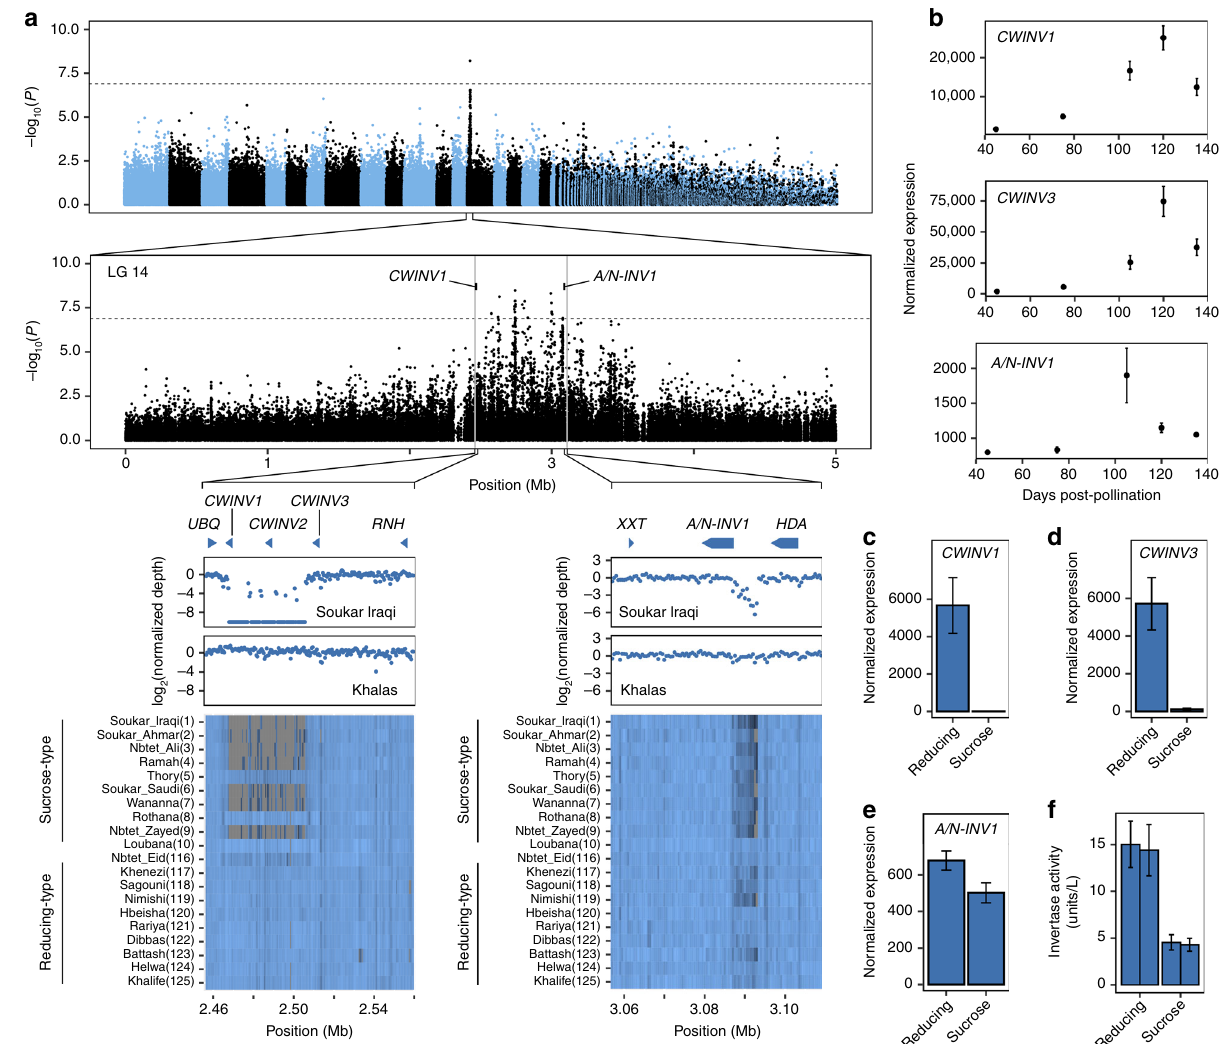
Fig. 5 GWAS mapping of sugar composition in date palm fruit and functional characterization of candidate genes. a Top: Manhattan plot GWAS results for tamar stage fruit sugar composition measured as [sucrose]/[sucrose + glucose + fructose]. The plot is based on analysis conducted with the randomly downsampled SNP call set. Middle: Manhattan plot of the region on LG 14 containing signi fi cant associations based on analysis of all SNPs on this linkage group. Dotted lines represent the Bonferroni signi fi cance threshold. Gray vertical lines represent boundaries of the regions highlighted below. Bottom: Close-up of two highlighted regions with invertase genes in the vicinity of the GWAS peak. From top to bottom, gene models, normalized coverage depth in 500 bp windows for a sucrose-type variety (Soukar Iraqi), a reducing sugar-type variety (Khalas), and a heatmap of normalized coverage depth (low coverage is dark blue to high coverage light blue; zero coverage = gray) of the ten most extreme sugar composition phenotypes at each end of the sucrose- type and reducing-type distributions (see Supplementary Figs. 12 and 13 for all samples). Numbers in parenthesis next to variety names are the sucrose to total sugar rank among the 125 varieties with sugar measurements, where (1) is highest sucrose. b Expression of three candidate invertase genes in developing fruit at different stages post pollination (mean ± s.e.m.) in the Khenezi variety. c – e Differential gene expression of khalal stage fruit between four sucrose-type and four reducing-type varieties at three candidate invertase genes (mean ± s.e.m.). f Invertase enzyme activity in khalal stage fruit in two reducing-type and two sucrose-type varieties (mean ± s.d.). Source data are provided as a Source Data fi The positional invertase candidates include an alkaline/neutral (which we refer to as CWINV2 ), with close homology to CWINV1 invertase ( A/N-INV1 ; gene ID chr14G0028200) located near the and CWINV3 , and located between these two genes at positions center of the GWAS peak at 3.087 Mb of the LG 14 assembly 2,489,373 to 2,485,592 on LG14 (Fig. 5a). However, this coding (Fig. 5a, Supplementary Data 6), and two adjacently-linked cell region has multiple frame-shift mutations in our PacBio assembly wall invertases ( CWINV1 and CWINV3 , gene ID chr14G0022900 and chr13G0023100, respectively) and located at the 5 ′ end of the GWAS region at approximately 2.469 and 2.512 Mb (Fig. 5a). The CWINV1 and CWINV3 proteins show 98.58% amino acid identity, suggesting these are tandem duplicates of each other. We check for additional un-annotated copies of invertase in this region by aligning predicted transcripts for each of the three genes to this region, and recovered a minus strand sequence